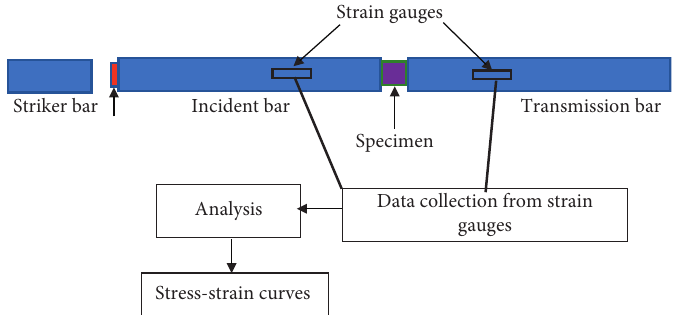
Figure 2: Schematic of conventional split-Hopkinson pressure bar